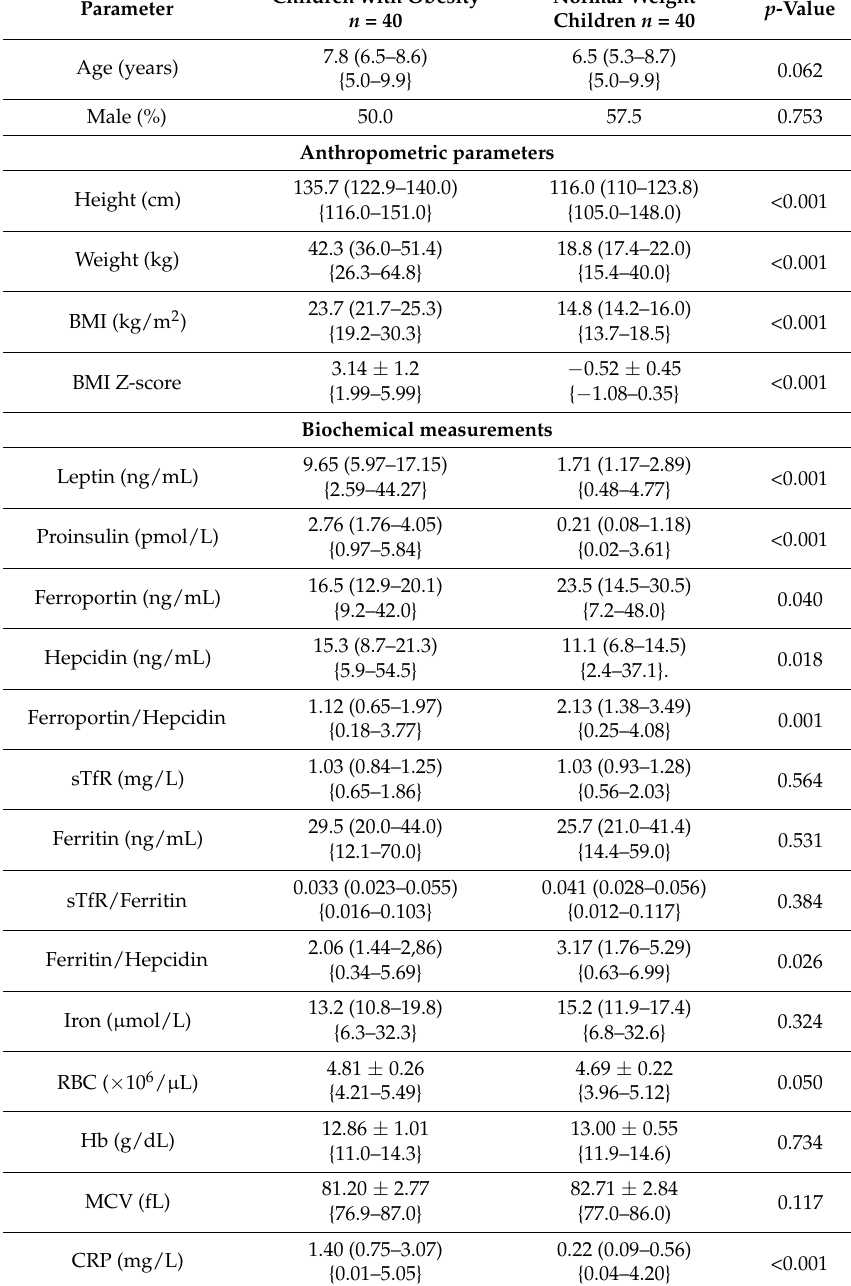
Table 1. Clinical and biochemical characteristics in prepubertal children with obesity and in normal-weight